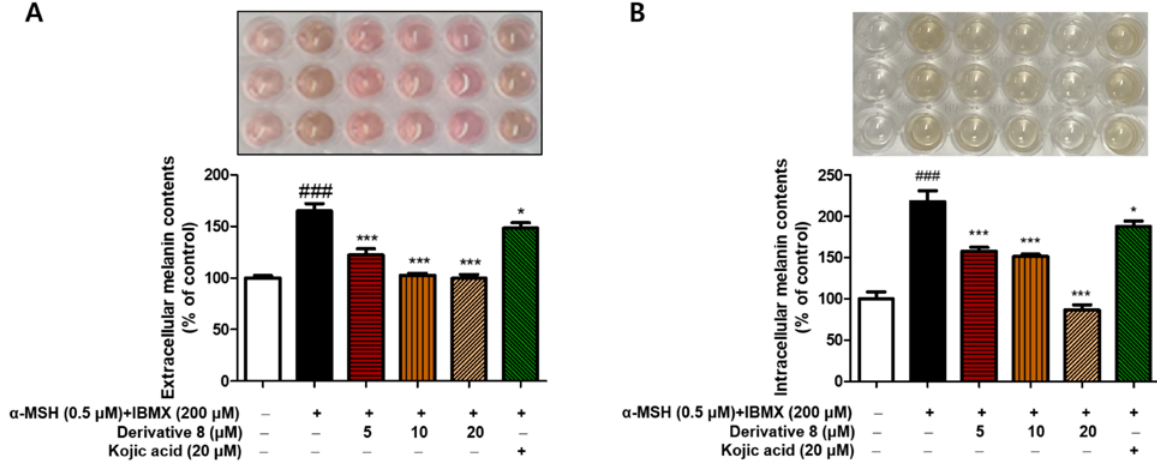
Figure 8. Inhibitory effects of BABT derivative 8 on extracellular ( A ) and intracellular ( B ) melanin production in B16F10 murine melanoma cells. After exposure of B16F10 cells to derivative 8 for 1 h at four different concentrations (0, 5, 10, and 20 µM), the cells were treated with stimulators (0.5 µM α -melanocyte-stimulating hormone ( α -MSH) plus 200 µM of 3-isobutyl-1-methylxanthine (IBMX)) to increase melanogenesis. After 72 h of incubation, extracellular and intracellular melanin levels were determined by measuring the optical densities in the culture media and cell lysates, respectively, at a wavelength of 405 nm. Kojic acid at 20 µM was used as a positive reference control. All experiments were performed independently, thrice. Symbols (* and # ) are used to indicate the significant differences between columns. ### p < 0.001 for cells treated with stimulators vs. untreated control; * p < 0.05, *** p < 0.001 for cells treated with stimulators plus derivative 8 or kojic acid vs. cells treated solely with stimulators. Results are displayed as the mean ± standard error of the mean (SEM) of three experiments.